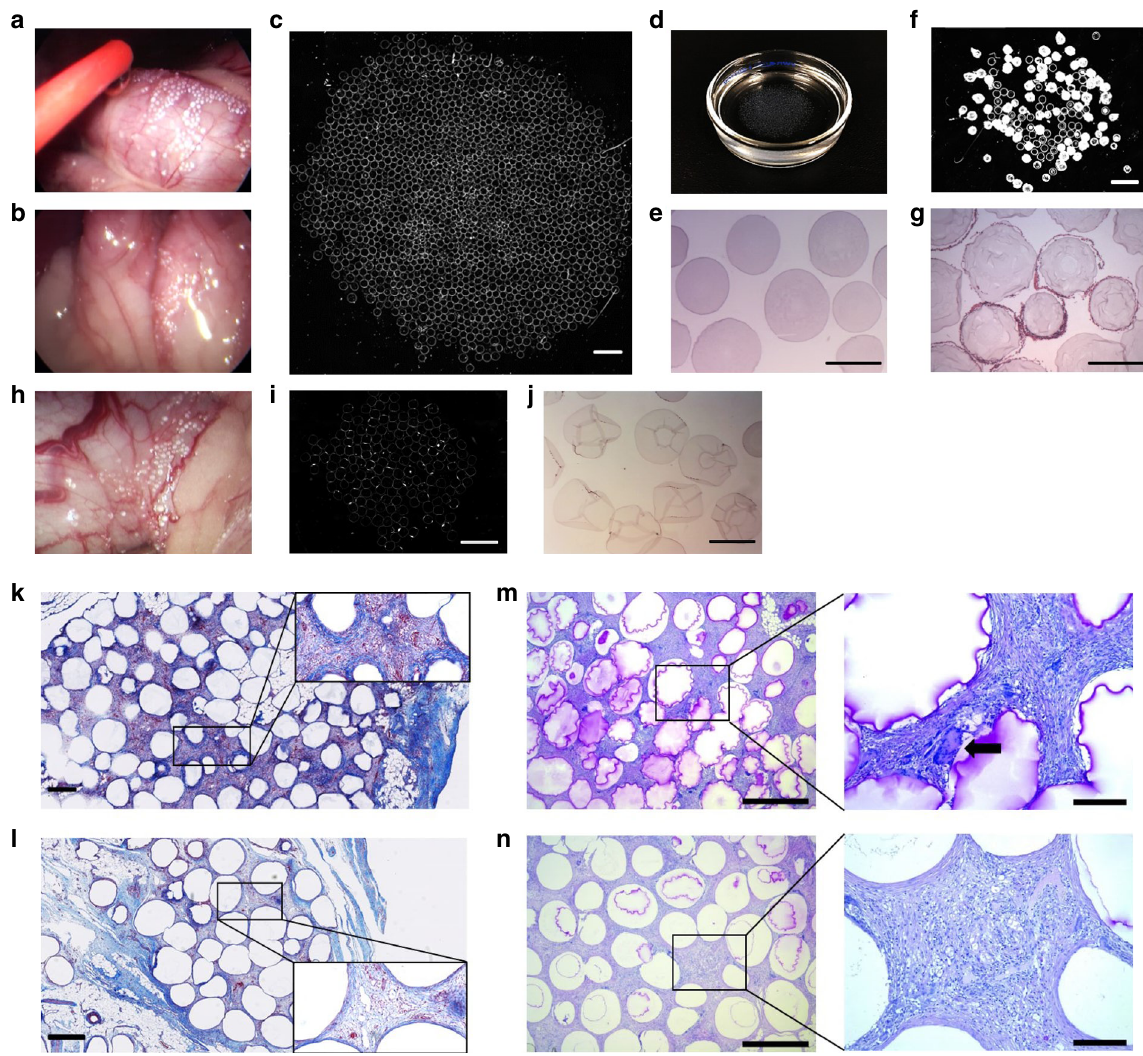
Fig. 4 SB modi fi ed alginates mitigate FBR in dogs and pigs. a A laparoscopic image during retrieval of SB-SLG20 alginate microcapsules, 45 days after intraperitoneal implantation in a dog. b A laparoscopic image during retrieval of SLG20 control microcapsules. c A phase contrast image of retrieved SB- SLG20 microcapsules ( n = 3; scale bar, 2 mm; see Supplementary Fig. 28 for complete data). d Retrieved SB-SLG20 microcapsules in a Petri dish. e H&E stained cross-sectional image of retrieved SB-SLG20 microcapsules (Scale bar, 500 μ m). f A phase contrast image of retrieved SLG20 microcapsules ( n = 1; scale bar, 2 mm). g H&E stained cross-sectional image of retrieved SLG20 microcapsules (Scale bar, 500 μ m). h A laparoscopic image during retrieval of SB-SLG20 alginate microcapsules, 90 days after intraperitoneal implantation in a dog. i A phase contrast image of retrieved SB-SLG20 microcapsules ( n = 2; scale bar, 2 mm; see Supplementary Fig. 29 for complete data). j H&E stained cross-sectional image of retrieved SB-SLG20 microcapsules (Scale